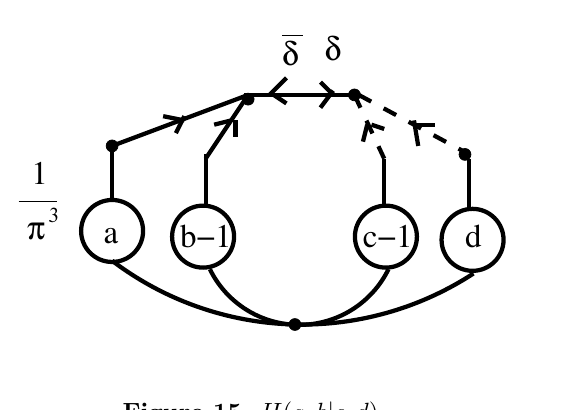
Figure 15 . H ( a; b j c; d